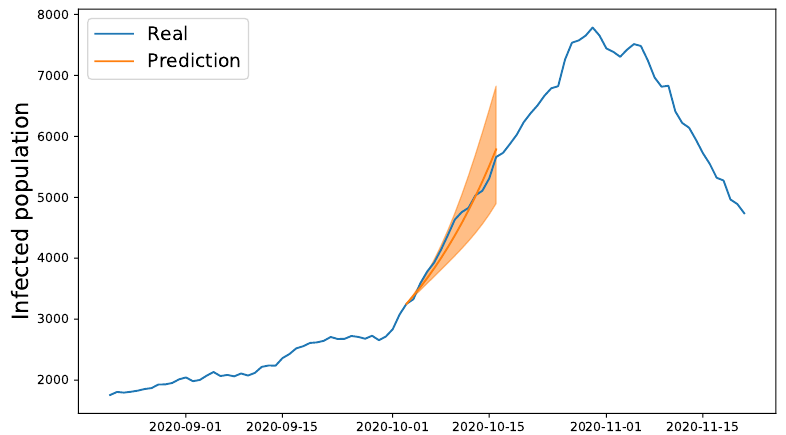
Figure 7. Prediction of the evolution of the number of positive cases from 4 September with a confidence interval of 80 %, assuming that no restrictive measures are applied. The prediction extends up to 20 days, which is the intended prediction range.